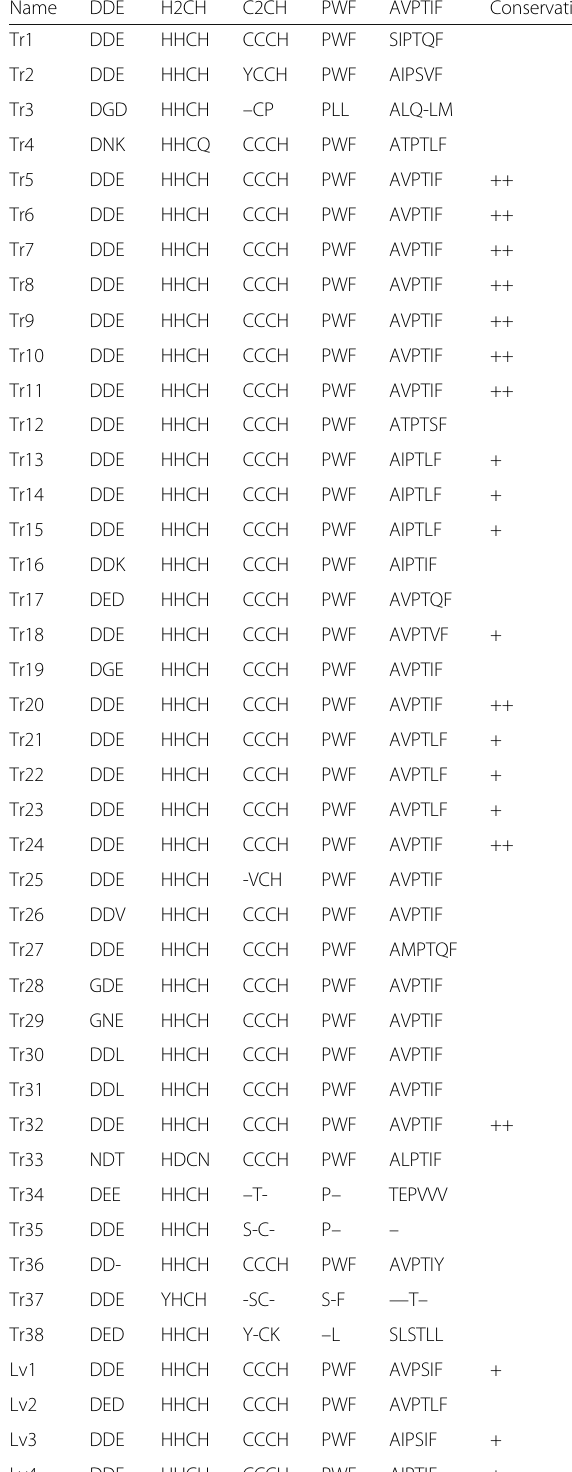
Table 2 Amino acid residues in conserved motifs of